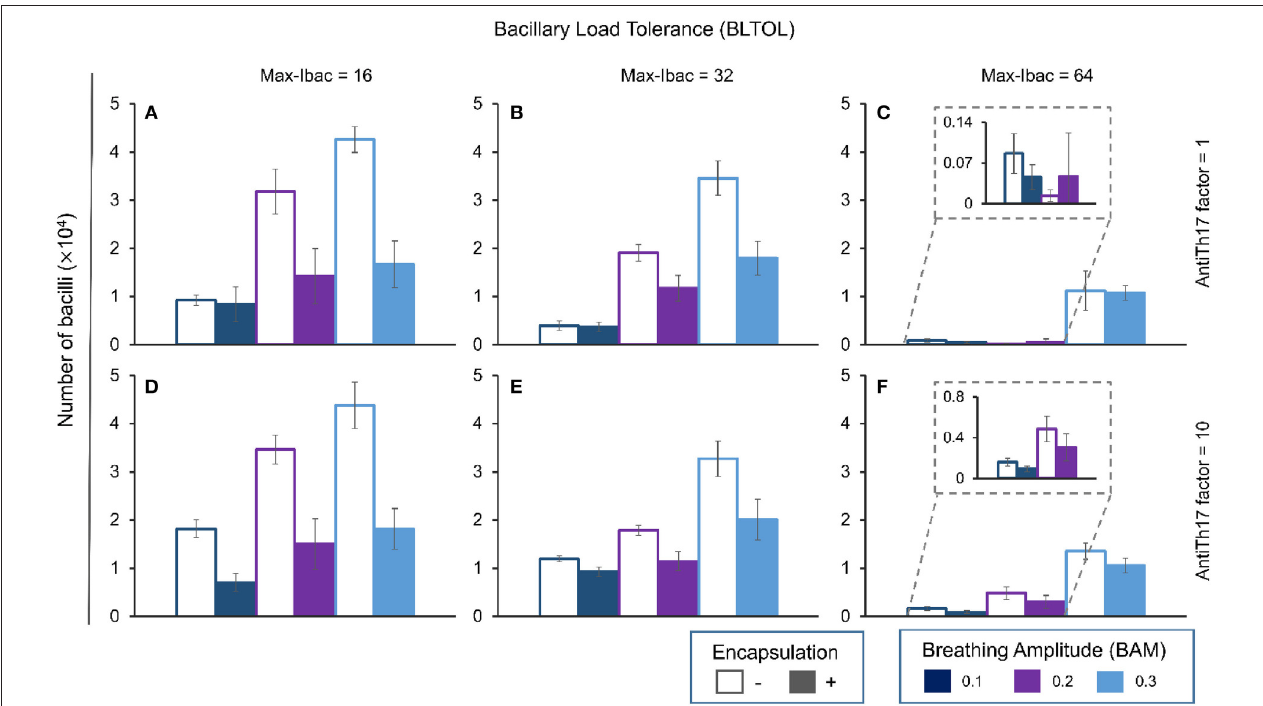
FIGURE 7 | Influence of different parameters on the number of killed bacilli at day 42. Maximum bacillary load per macrophage (BLTOL): 16 (A,D) , 32 (B,E) , 64 (C,F) . AntiTh17 factor: 1 (A–C) , 10 (D–F) Encapsulation factor: − = no encapsulation, + = encapsulation. Breathing amplitude (BAM): 0.1, 0.2, 0.3. Bars indicate the mean of 10 runs.